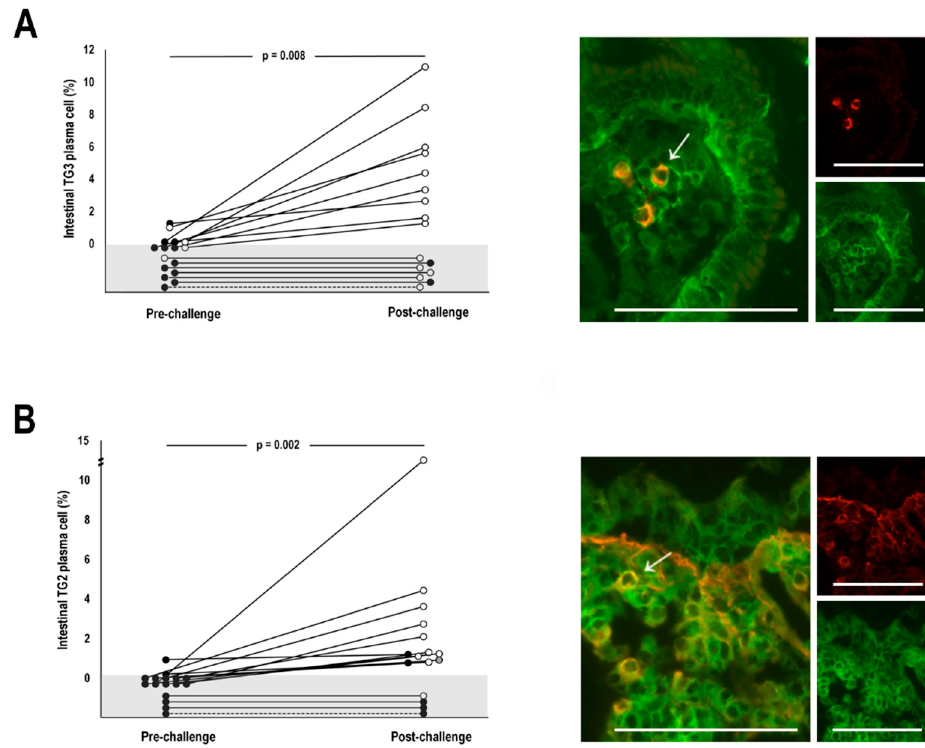
Figure 1. The percentage of transglutaminase (TG) 3- ( A ) and TG2-specific plasma cells ( B ) of all intestinal plasma cells in dermatitis herpetiformis patients at pre- and post-challenge. The grey area represents the absence of plasma cells. The black circles in A indicate negativity for serum TG3 antibodies and in B for both endomysial and TG2 antibodies, while the white circles indicate positivity. The grey circle in B indicates one individual with positive EmA but missing data for TG2 autoantibodies. Representative immunofluorescent pictures showing specific plasma cells (indicated with arrows) are shown on the right. The colour yellow indicates the colocalization of recombinant TG3 or TG2 (red) with plasma cell marker CD138 (green). Scale bar = 100 µm. A p -value < 0.05 was considered significant.